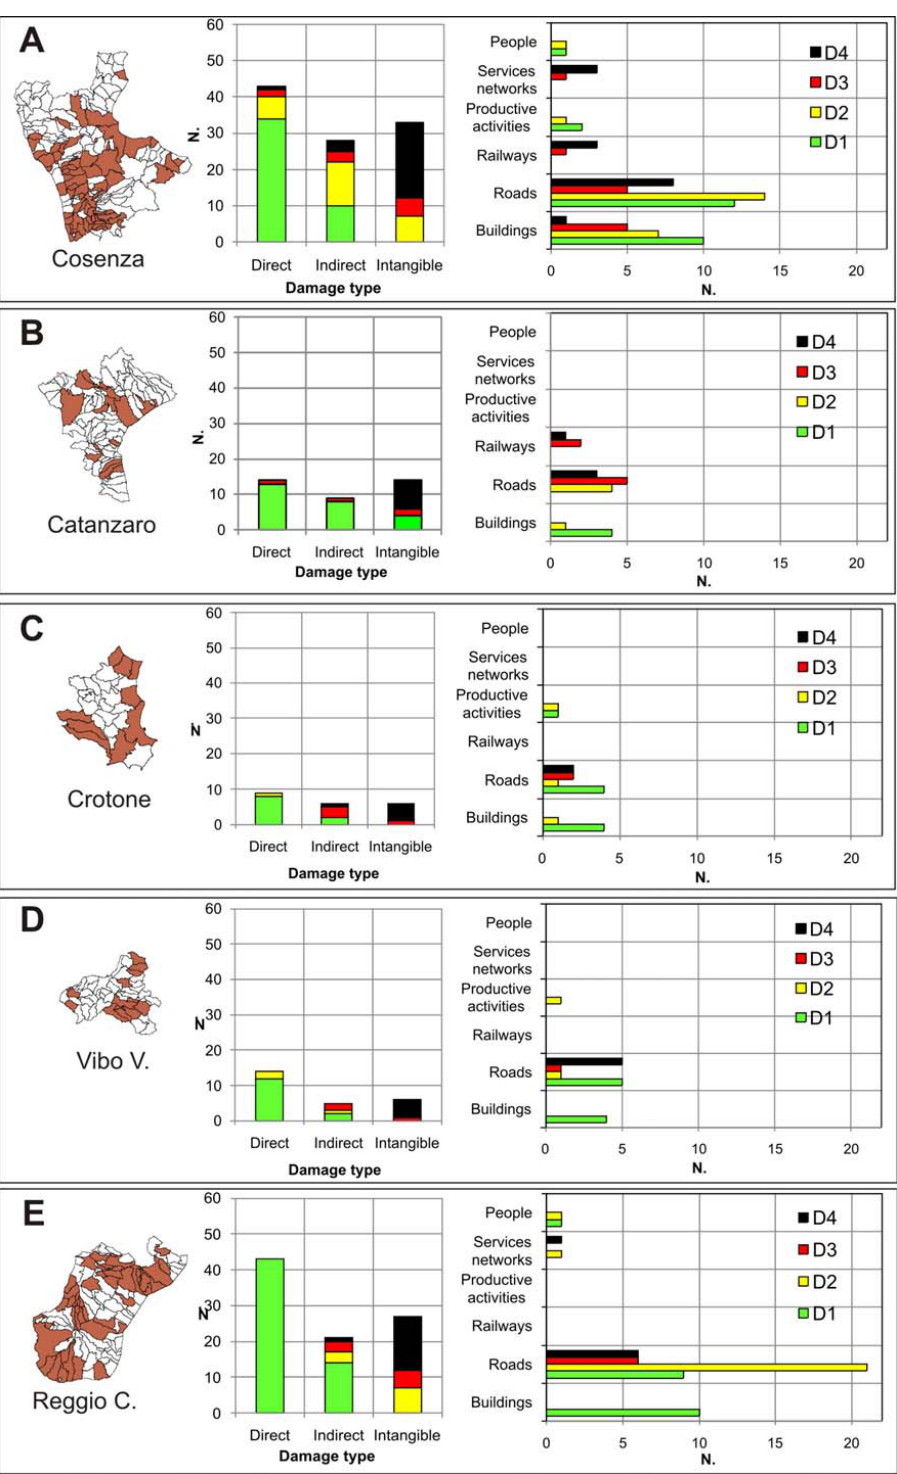
Fig. 1. Impact of the 2009 landsliding event on the provinces of Calabria. For each province, the map shows the location of municipalities damaged during the event. In the first histograms on the left of each provincial map, the damaged municipalities were classified according to the type of damage suffered (direct, indirect and intangible), and, in the second ones, according to the type of damaged elements. N is the number of municipalities damaged by landslides during the event, and the colours of the bars are set according to the damage levels, as is shown in the